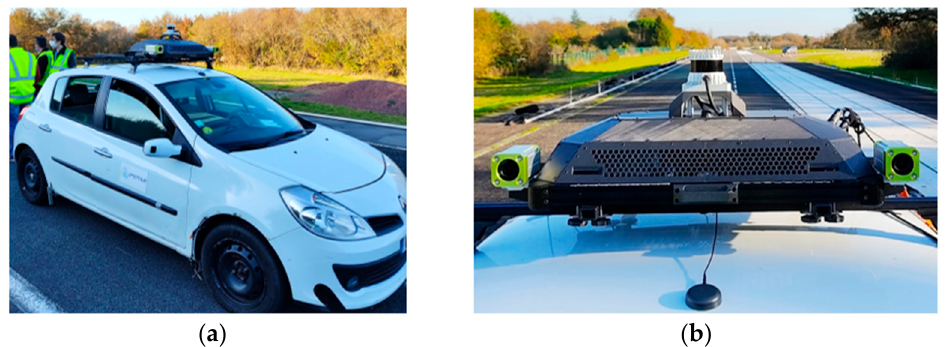
Figure 2. ( a ) Perception and localization system installed on an experimental vehicle; ( b ) zoom of the PLS.